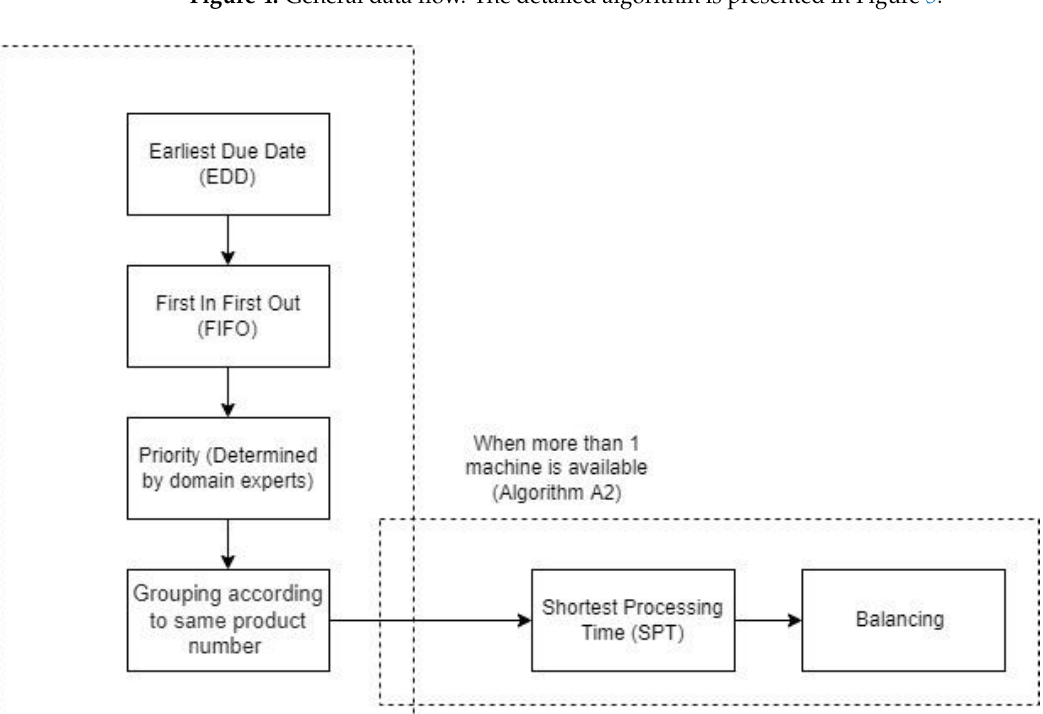
Figure 4. General data flow. The detailed algorithm is presented in Figure 5.